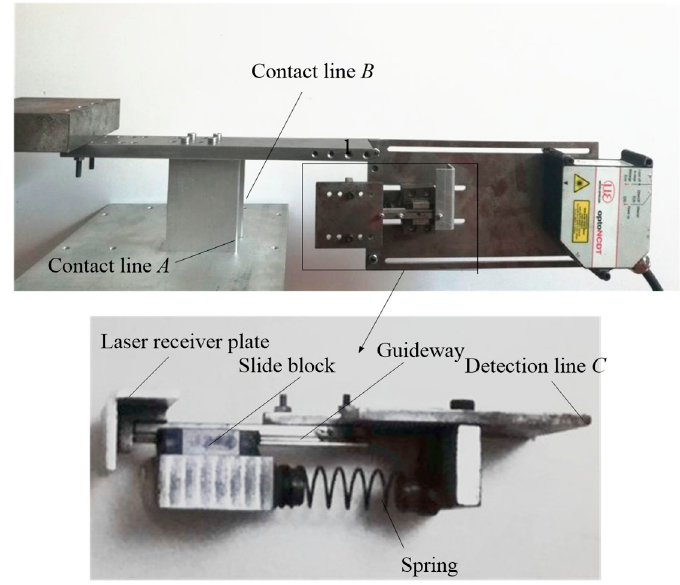
Figure 5. Measuring mechanism for measuring two vertical parallel surfaces.